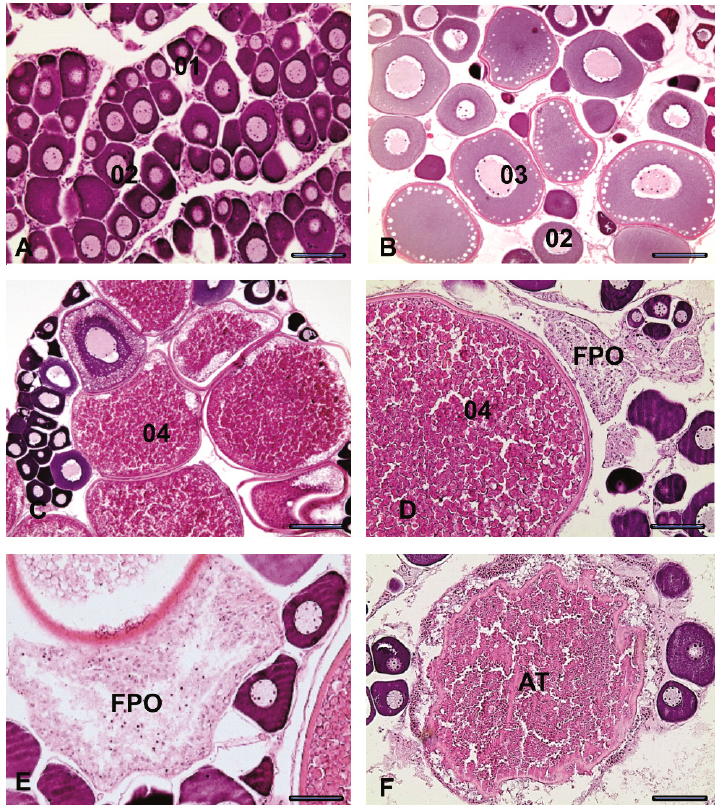
FIGURE 1 | Histological sections of ovaries of Leporinus piau stained by HE. ( A ) Ovary in rest (F1) with initial perinucleolar oocytes (O1) containing basophilic cytoplasm and nucleus with various nucleoli and advanced perinucleolar ovocytes (O2) containing finely granular cytoplasm and nucleus with nucleoli close to the nuclear envelope. ( B ) Beginning of maturation with the appearance of pre-vitellogenic follicles with characteristic cortical alveoli (O3) in the peripheral ooplasm. ( C ) Maturation/mature (F2) with vitellogenic oocyte (O4) and cytoplasm filled with yolk globules, thin zona radiata (ZR), and squamous follicular cells. ( D ) Spawned (F3) with post-ovulatory follicles (POF) alongside follicles at all stages of development. ( E ) Detail of post-ovulatory follicle (POF). ( F ) Detail of atresic follicle (AF). Bars: A and B = 200μm; C = 300μm; D and F = 150μm; E =